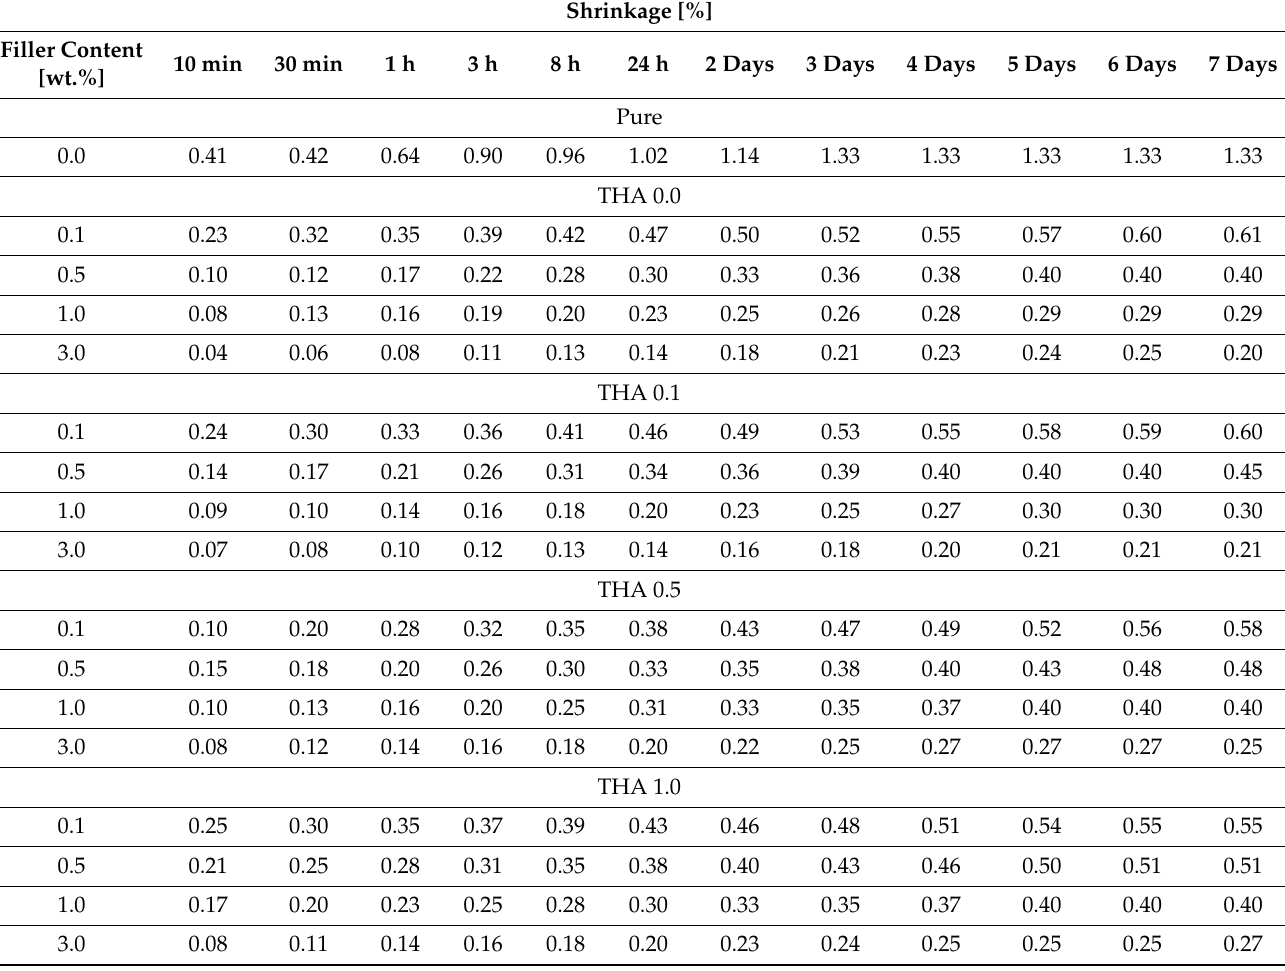
Table 6. Shrinkage of silicone pressure-sensitive adhesives with different filler